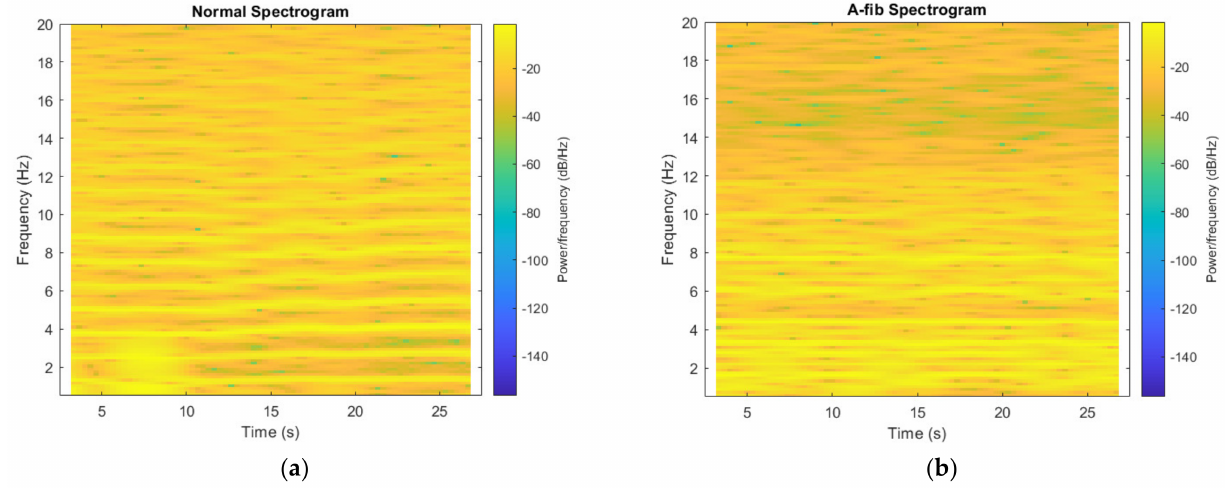
Figure 4. Spectrograms obtained from ( a ) a normal sample; ( b ) an A-fib